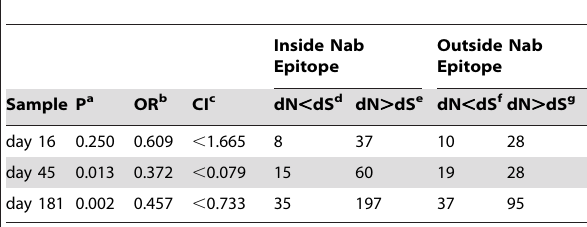
Table 3. Comparison of synonymous and non-synonymous substitutions inside and outside of the V1 Nab epitope region.